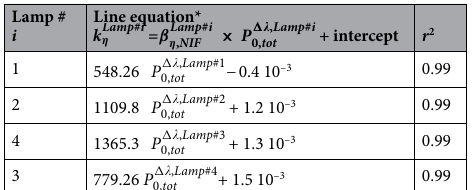
(cid:31) 0, tot , for the four